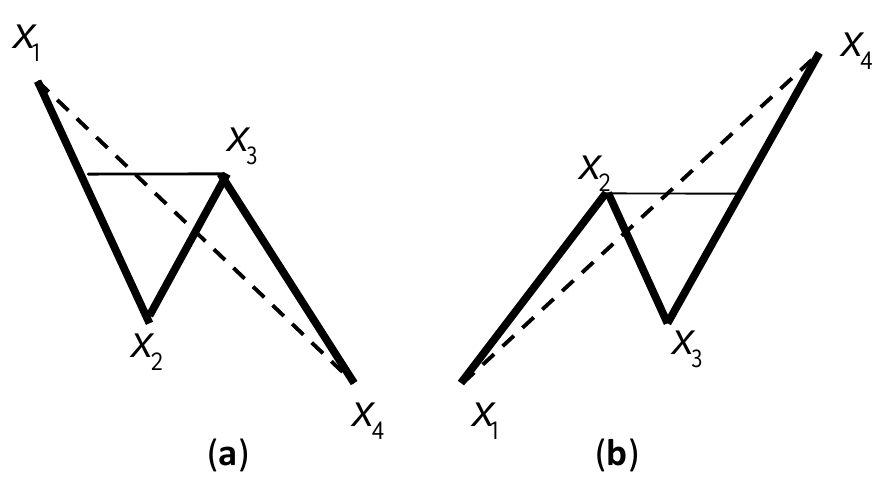
Figure 1. Criterion conditions of rain-flow counting